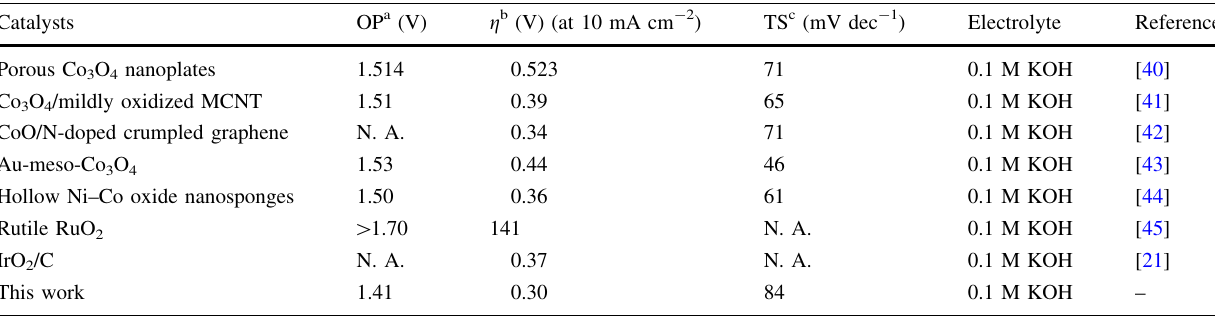
Table 1 Comparison of electrocatalytic activity with previous reported catalysts Catalysts